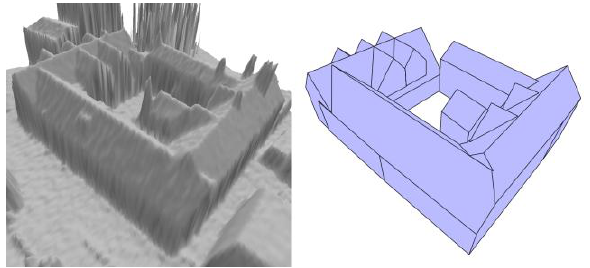
Figure 12 Digital surface model and reconstructed